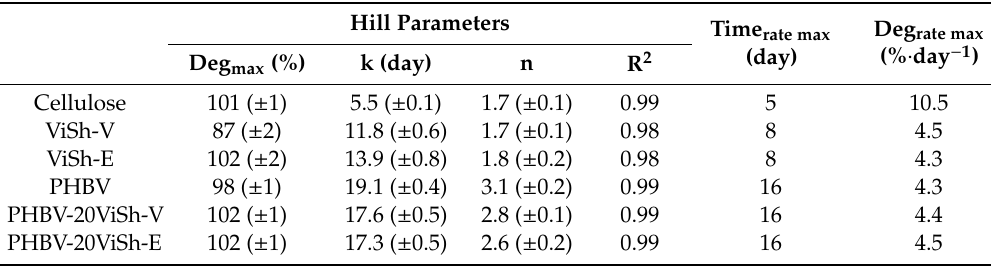
Table 3. Hill parameters (Deg max , k, n) and related biodegradation indicators (Time rate max, Deg rate max ) of fillers and composite